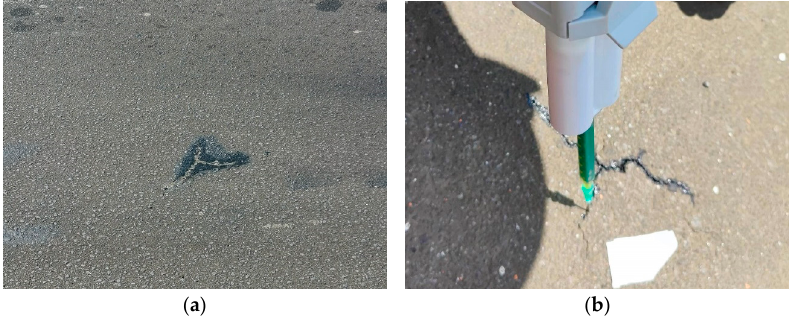
Figure 8. Irregular cracks on XHMB pavement. ( a ) chicken ‐ feet crack, ( b ) irregular crack.